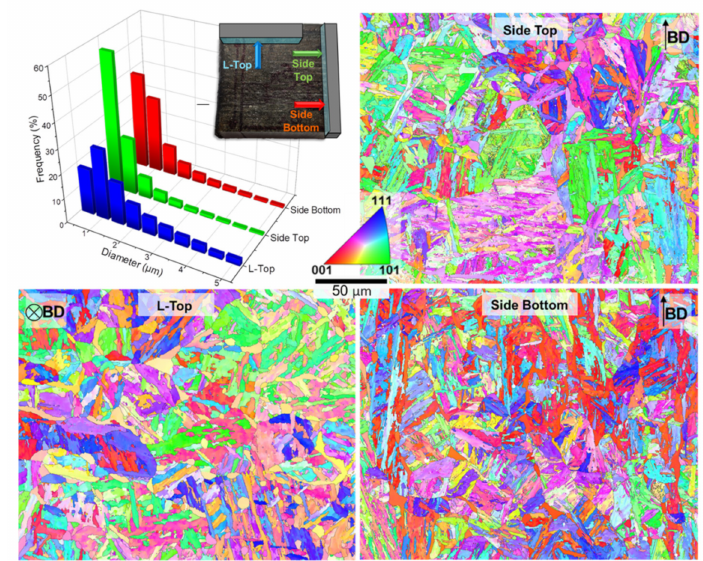
Figure 3. Grain sizes at three different center locations in as-fabricated conditions were determined and are plotted in the top left. IPF maps were taken from the center of each sample. The build direction is shown in a corner of each IPF map.